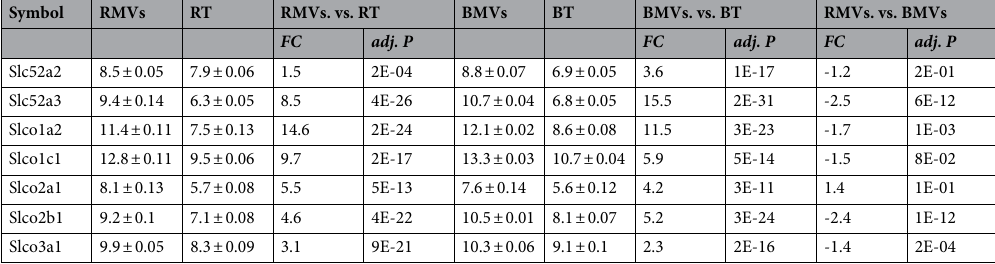
Table 3. List of solute carrier genes differentially expressed in rat retina and/or brain microvessels vs. retina and brain tissue samples. Results are mean ± SEM of log 2 transformed microarray intensity values (n = 6). RMVs, retinal microvessels; RT, retinal tissue; BMVs, brain microvessels; BT, brain tissue; FC , fold change; adj. P , false discovery rate adjusted p value.SLC, solute